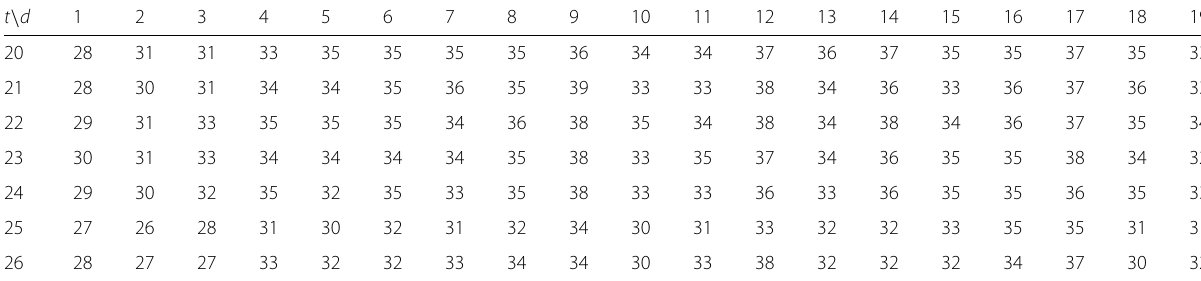
Table 1 Data for actual